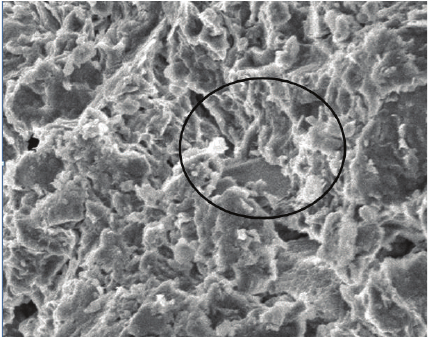
Figure 11: Possible onset of formation of ettringite in soil stabilized with 7% lime and 1%